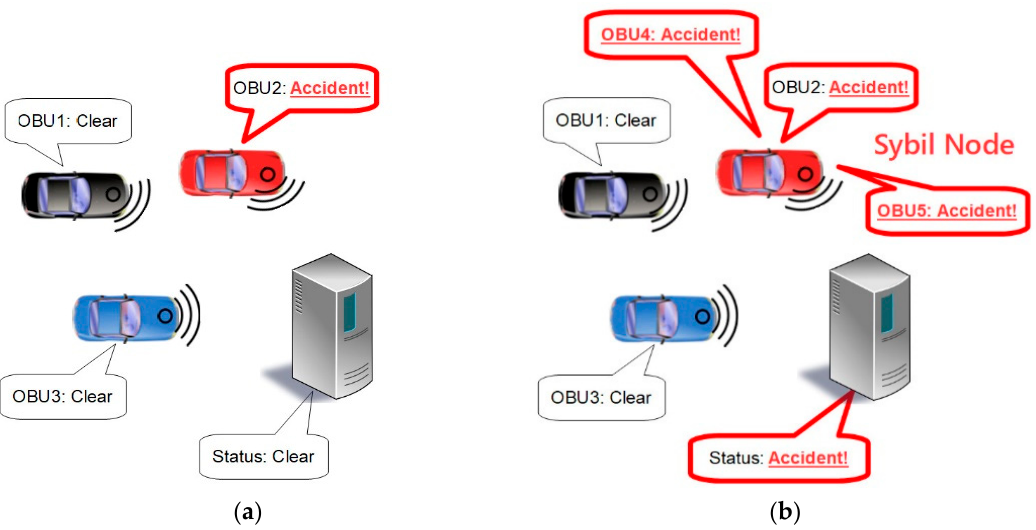
Figure 2. Example of greedy driver attack: ( a ) Failed attempt using a single vote; ( b ) Successful attempt using Sybil attack to create additional votes.